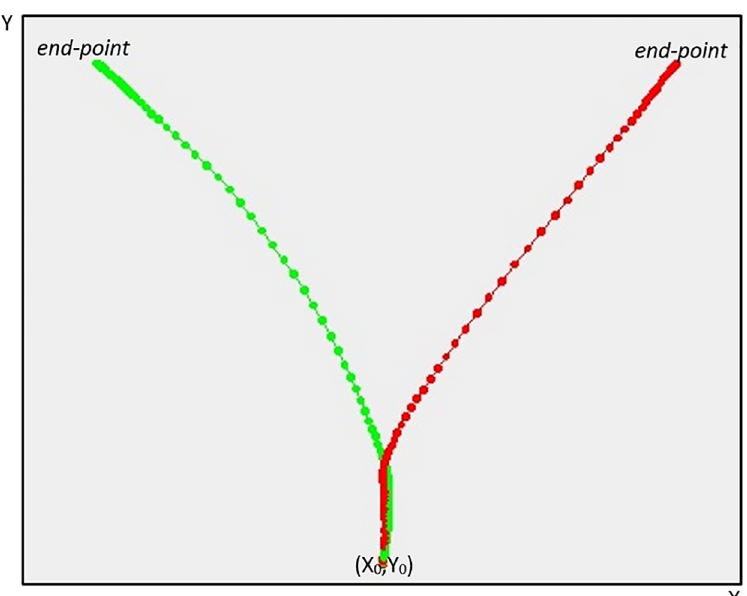
Fig 5. Trajectories for YES and NO responses. Responsesto the left responsebutton and to the right responsebutton are reportedseparately here. The trajectory in the two types of responses did not differ.